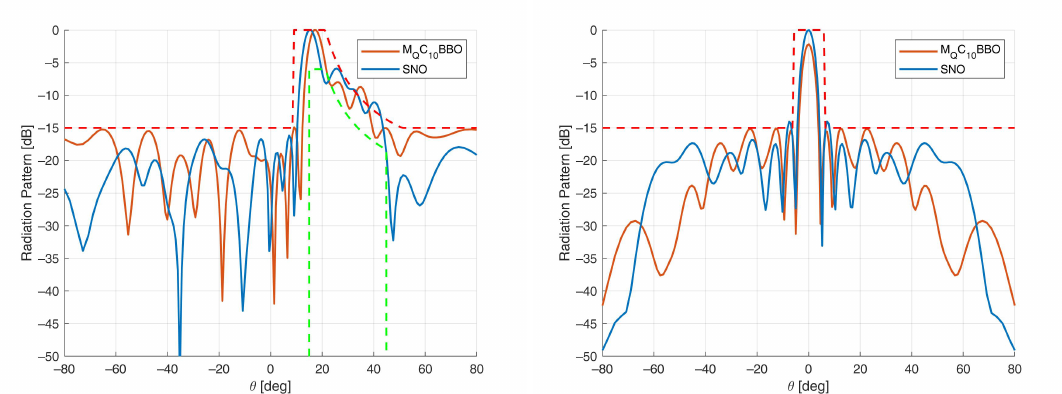
Figure 7. Comparison between the radiation patterns obtained with SNO and M Q C 10 -BBO in the E-plane ( left ) and H-plane ( right ).